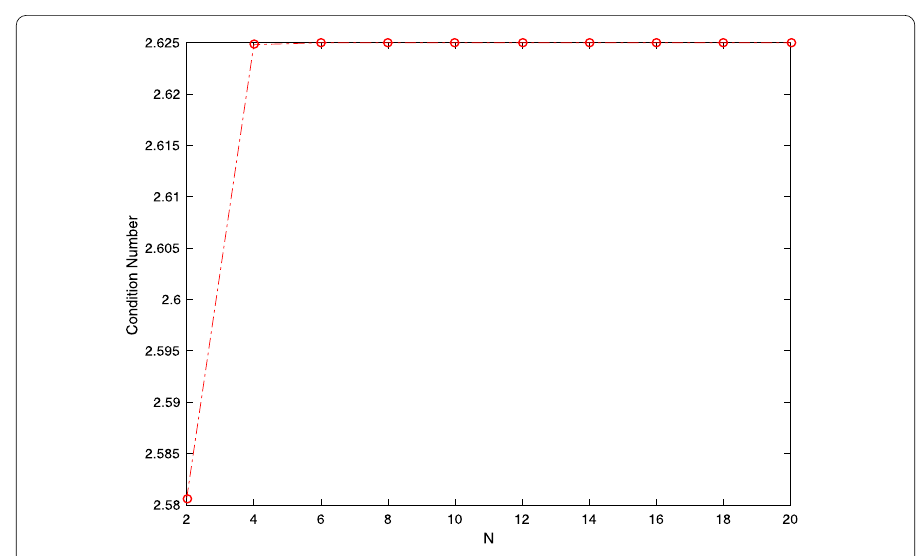
Figure 8 Condition number of the matrix S – T with Example